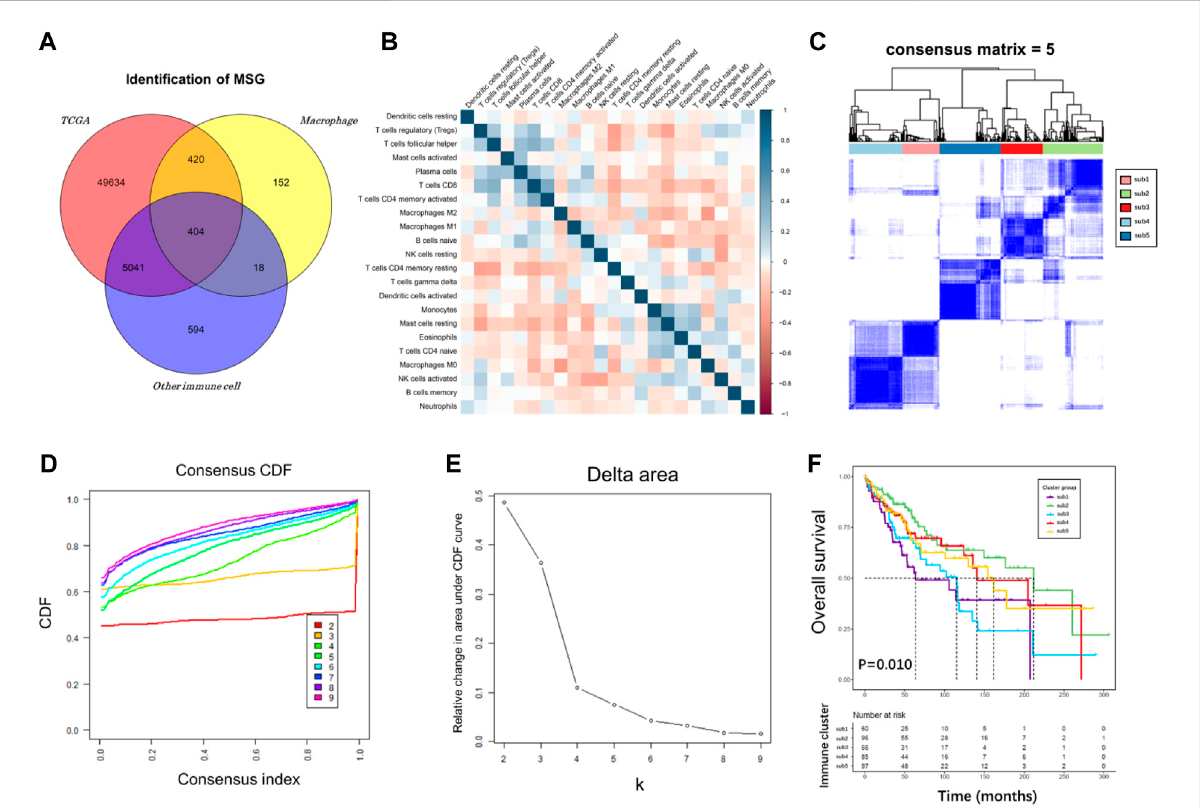
FIGURE 2 Immune subtype analysis of TCGA cohort. (A) Venn diagram plot among TCGA, macrophage, and other immune cell genes. (B) Correlation heatmapforTCGAcancersamplesbasedontheCIBERSORT immunein fi ltrationalgorithm. (C – E) Consensusscore matrixforcancersampleswhen k = 5. A higher consensus score between two samples indicates that they are more likely to be assignedto the same cluster in different iterations. (F) A K-M survival curve of the fi ve immune